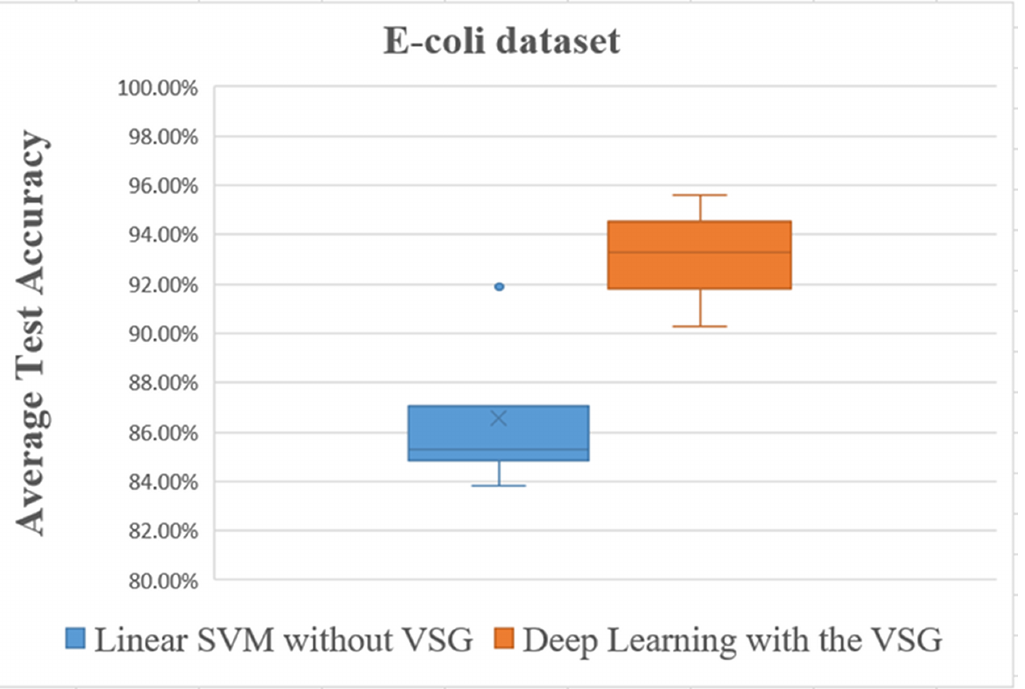
Figure 11. Overall comparisons of experimental results using the E. coli dataset.